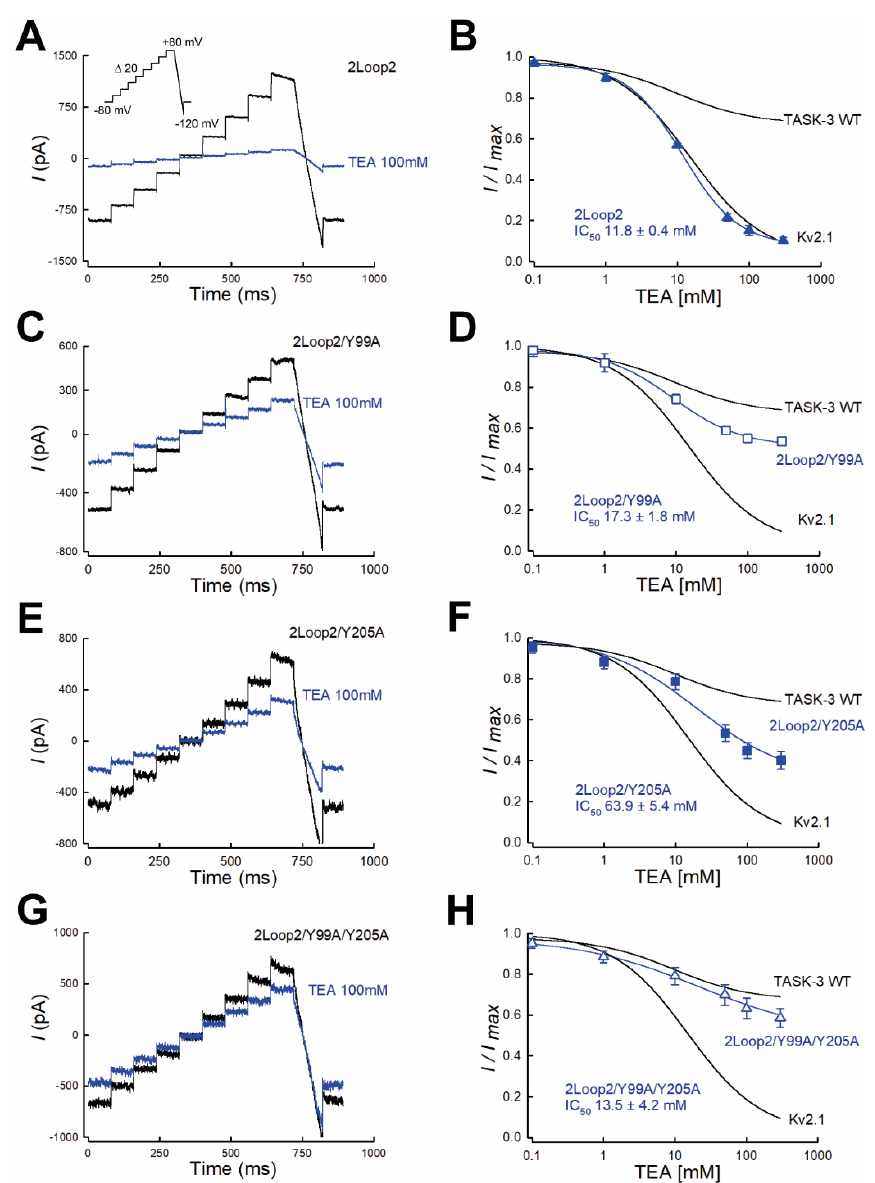
TASK-3/2loop2/Y205A mutant presented a maximal inhibition of 59% and had an IC 50 value of 63.9 ± 5.4 mM (Figure 5F).